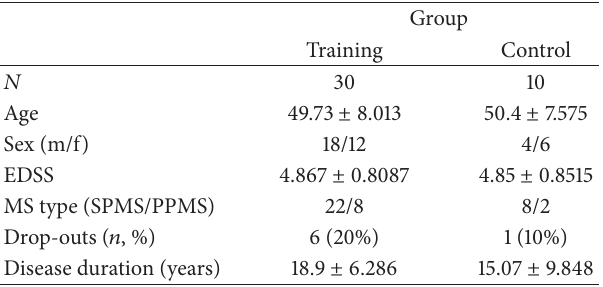
Table 1: Clinical baseline characteristics of training and control